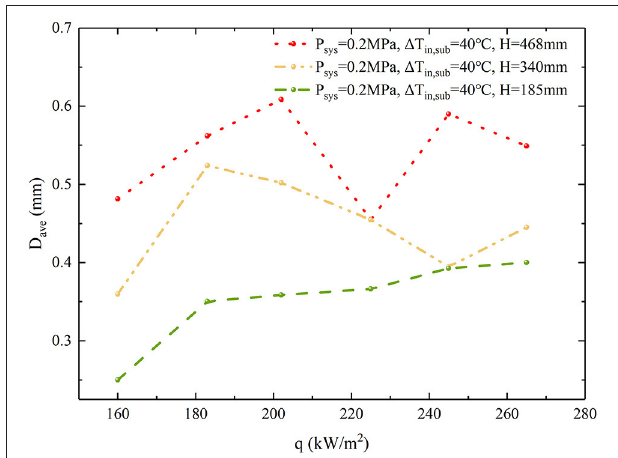
FIGURE 12 | The mean diameter of sliding bubble.